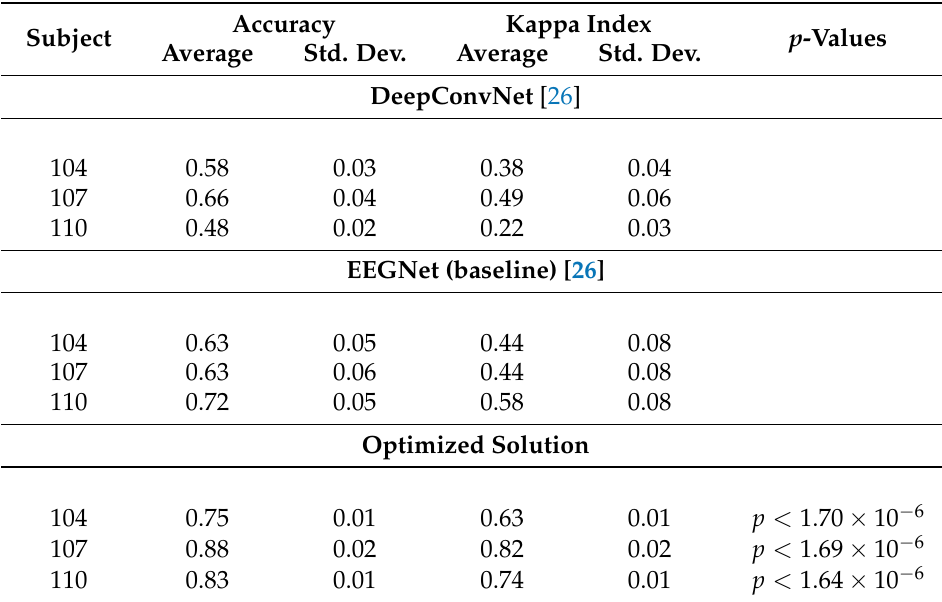
Table 4. Classification results and statistical validation.